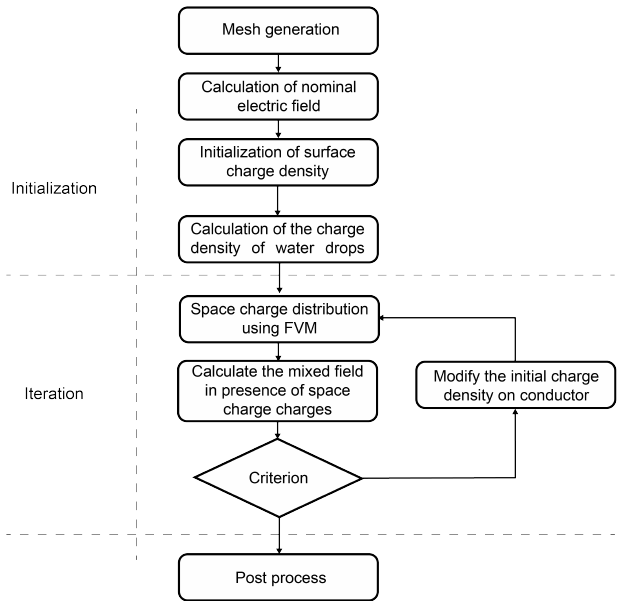
Figure 3. Flow chart of the ion flow field calculation.